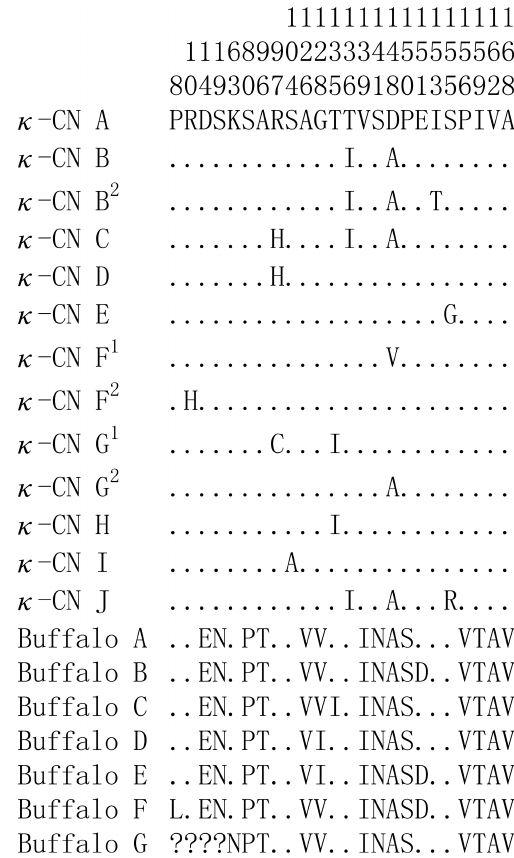
Figure 6. Sequence differences of κ -CN variants between buffalo and the species of the Bos genus. Number represents the position of the mature peptide. Dots ( · ) represents the identity with the κ - CN A. Amino acid substitutions are denoted by different letters. Missing information is indicated by a question mark